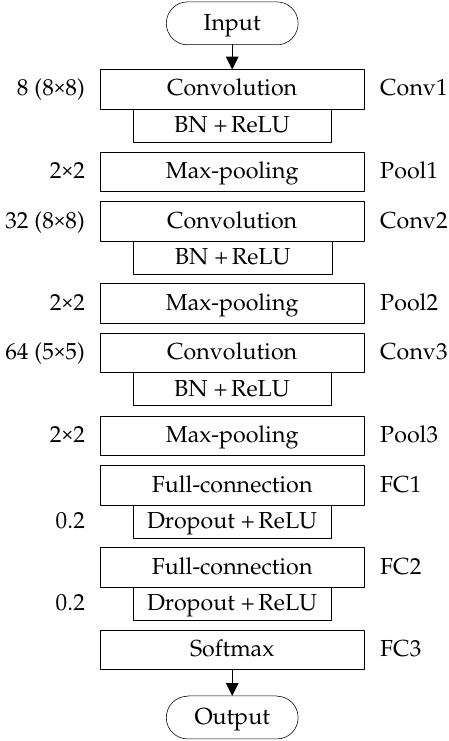
Figure 3. Structure of improved 2D LeNet-5 network for rolling-element bearing fault